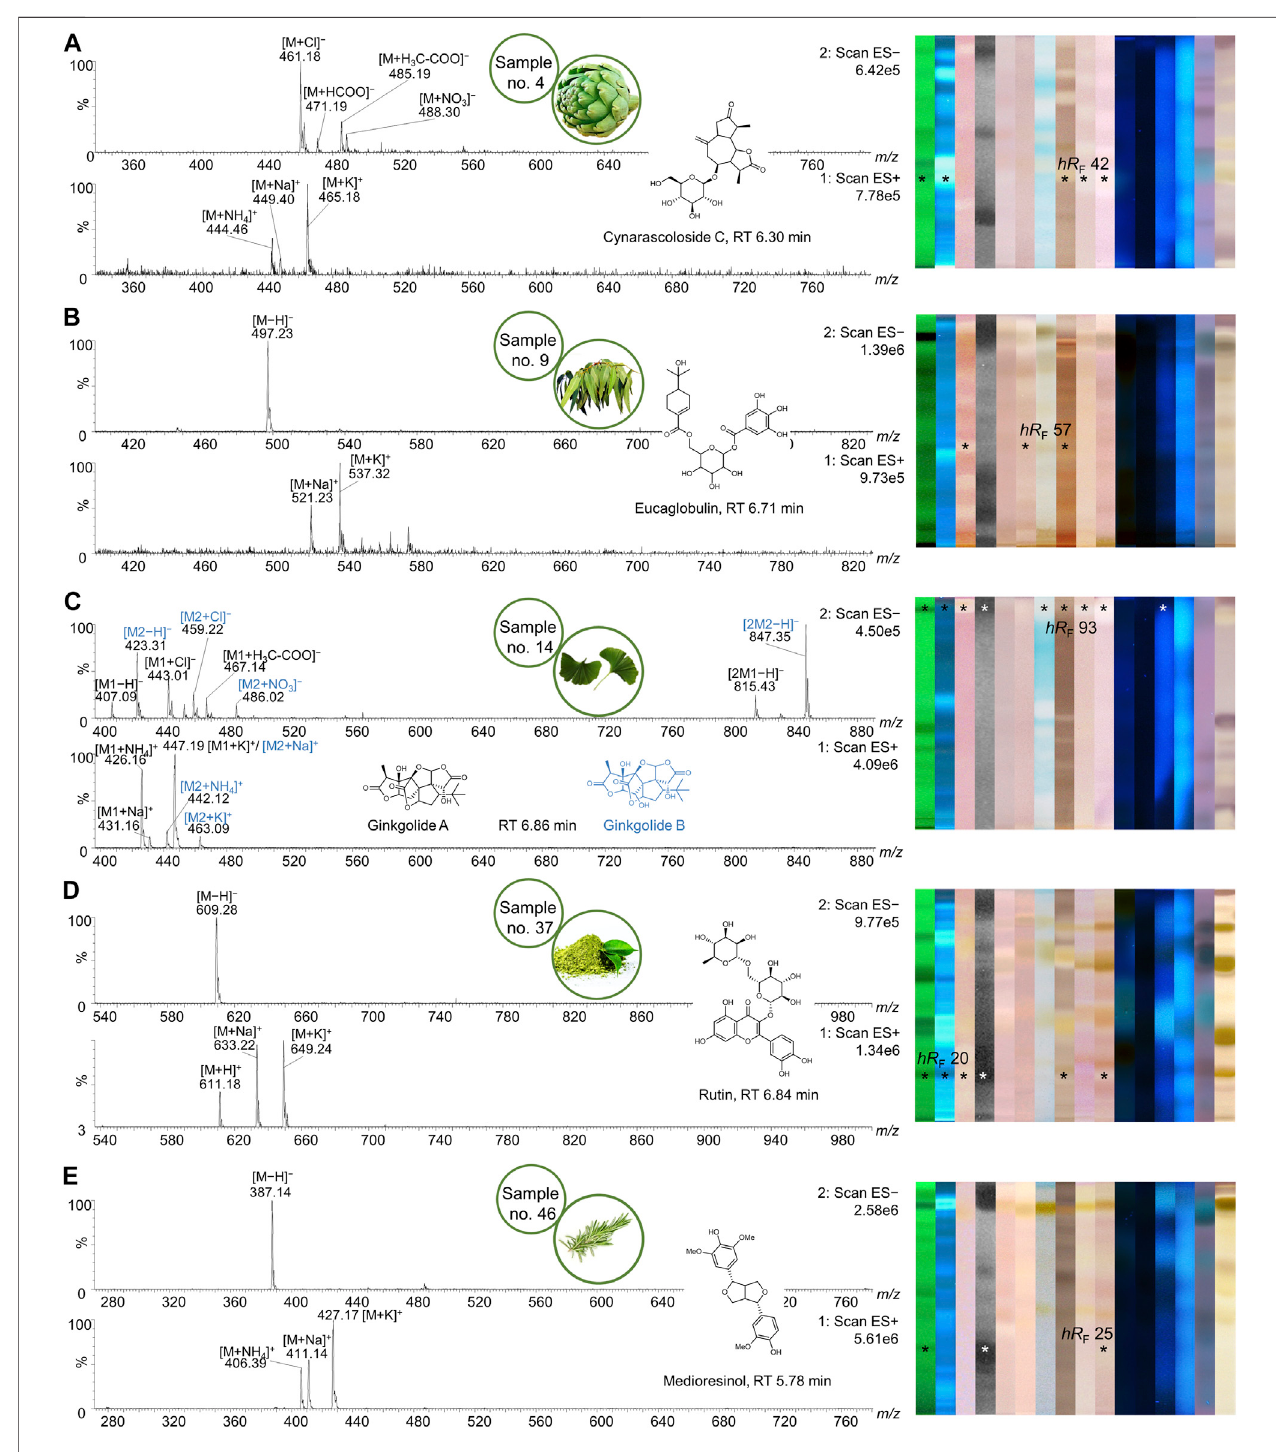
FIGURE 11 | Mass spectra of multipotent bioactive zones. NP-HPTLC − UV/Vis/FLD − EDA analysis as in Figures 2 – 4 , followed by heart-cut elution of the multipotent bioactive zones of artichoke (A) , eucalyptus (B) , ginkgo (C) , yerba mate green (D) , and rosemary (E) . Pure mass spectra of respective HPLC peaks are shown with their associated structural formula and respective HPTLC fi ngerprints (bioactive zones marked*).